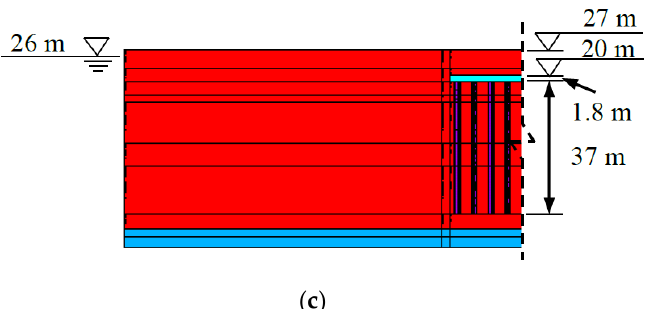
Figure 7. Different view of PRFs: ( a ) the model of Case 1 and Case 2; ( b ) the model of Case 3; ( c ) cross-section view of the models of three cases. Table 1. Parameters of raft, pile, and bedrock.